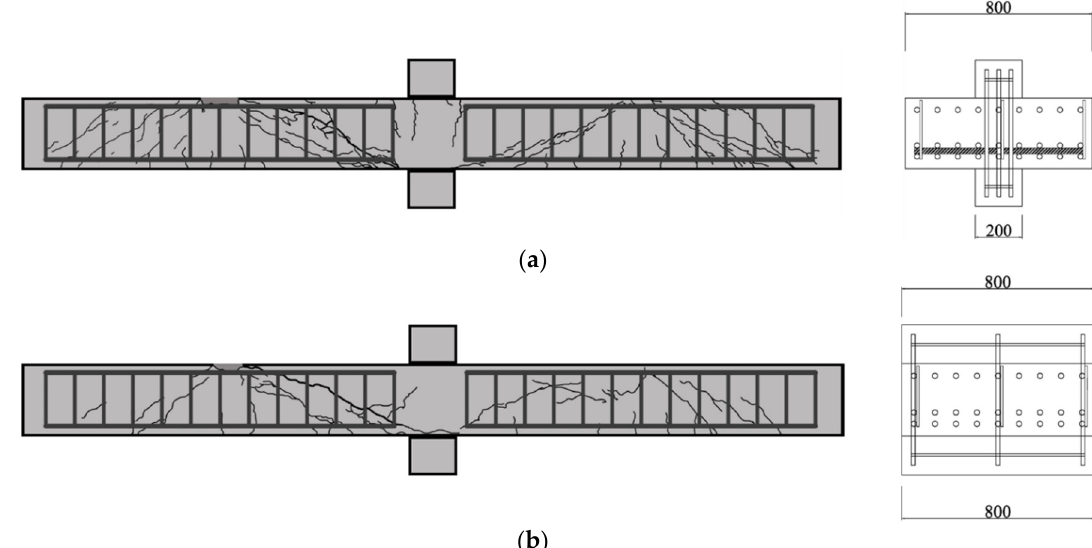
Figure 7. Crack pattern for various support width: ( a ) 2S-SB1; ( b ) 2S-SB4.